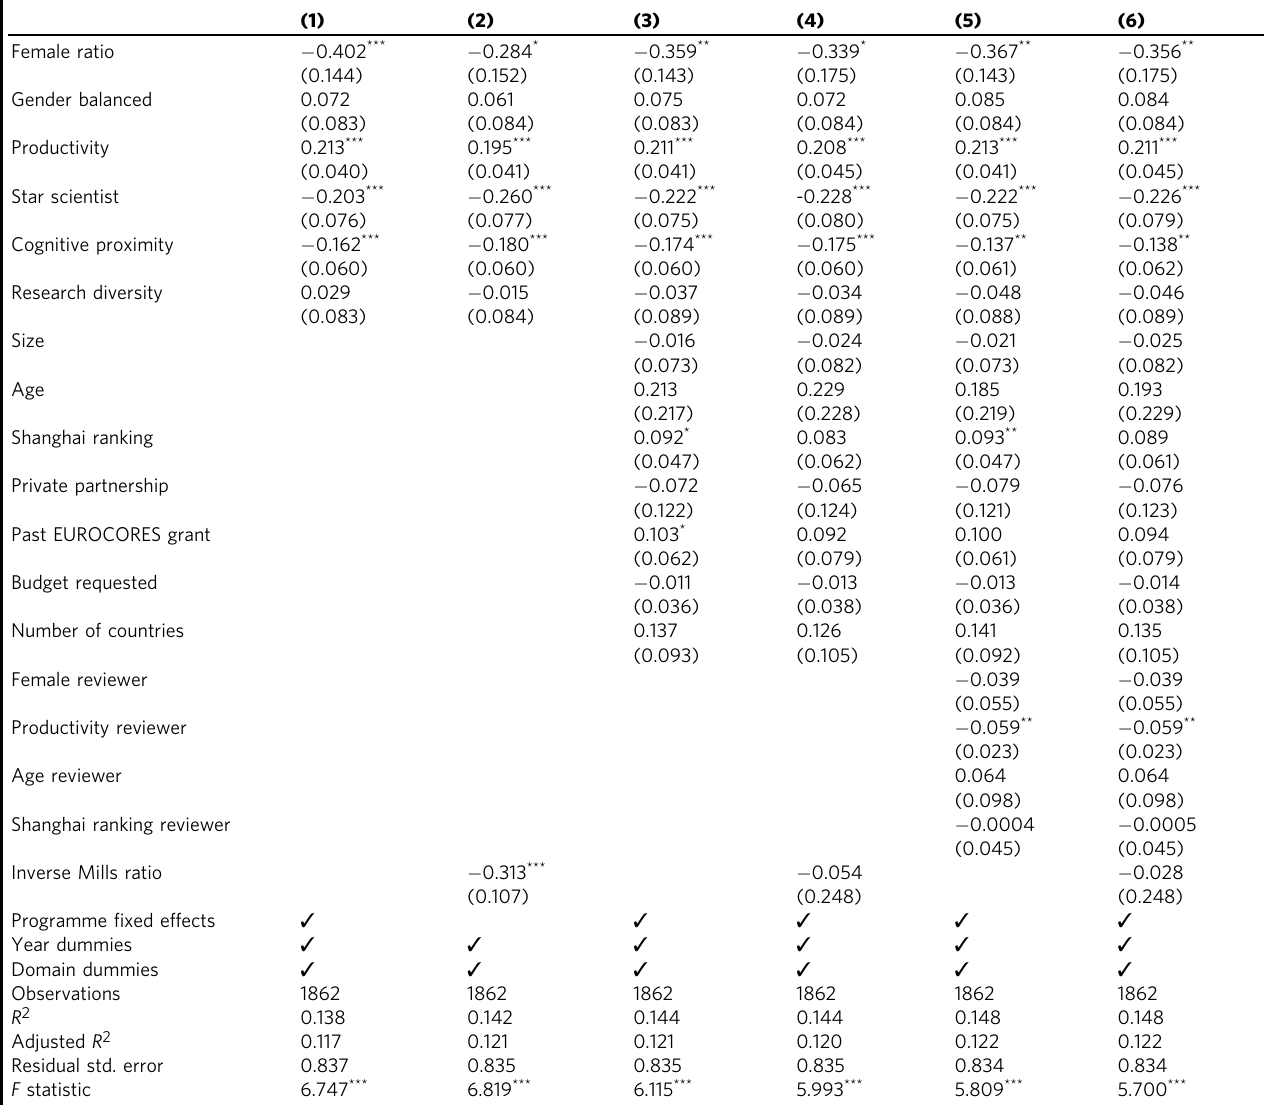
This tablereportscoef fi cients of the OLSestimation.Thedependentvariable is ‘ ReviewerScore ’ asde fi ned inTable S1. Allother explanatoryvariables arealsode fi ned in TableS1. Thesixmodels include different con fi gurations of explanatory variables to test the sensitivity of the estimation. Columns (2), (4) and (6) report Heckman ’ s two-step estimated coef fi cients and corresponding Inverse Mills Ratios. Robust standard errors in parentheses, clustered at programme-level: ***, **, *, indicate signi fi cance at the 1%, 5% and 10% level,